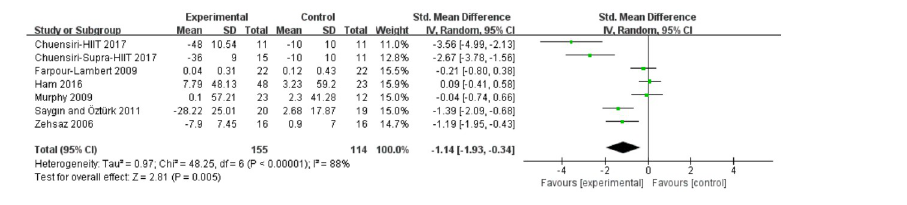
Fig 5. Forest plot of comparison: Triglycerides.